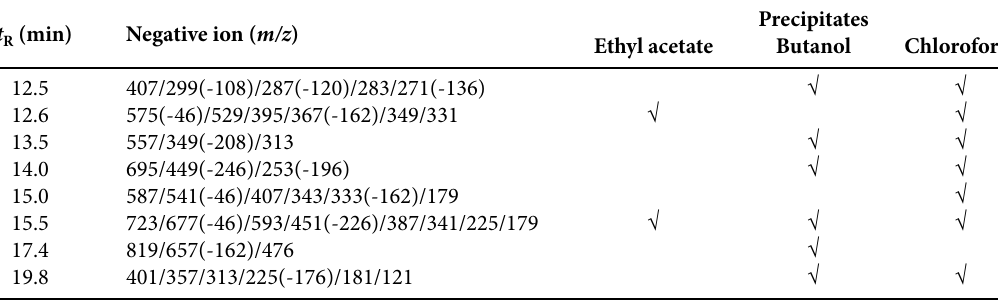
Table 3 . Detected saccharide-containing compounds from the precipitates of organic fractions t R